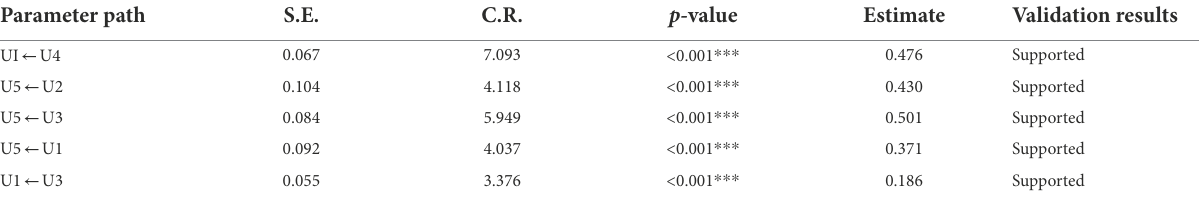
TABLE 5 Standardized path coefficients and hypothesis testing results. Parameter path